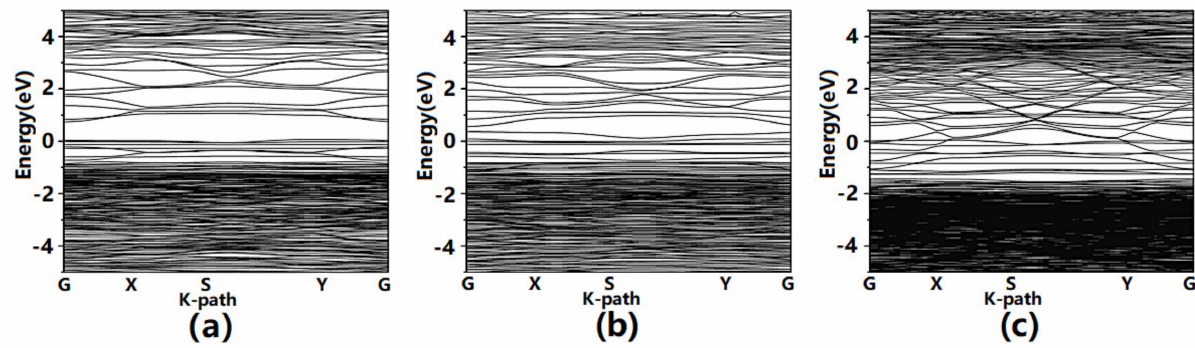
Figure 4. Band structures of 1 nm ( a ), 2 nm ( b ), and 3 nm ( c ) ITO near the Fermi level ( − 5 to 5 eV) at 100